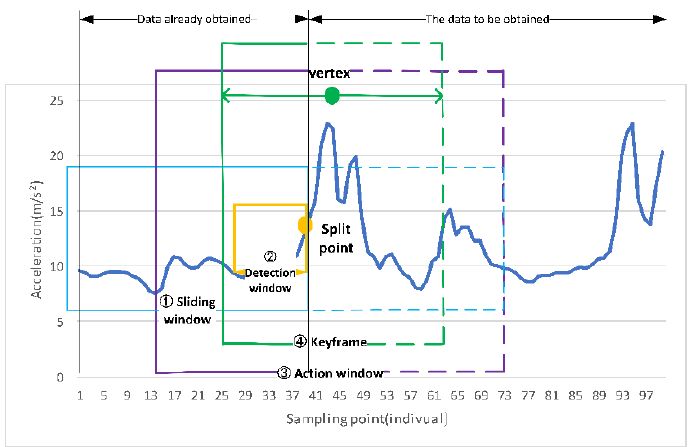
Figure 4. Schematic diagram of window segmentation point detection and key frame extraction method based on human table tennis action data.